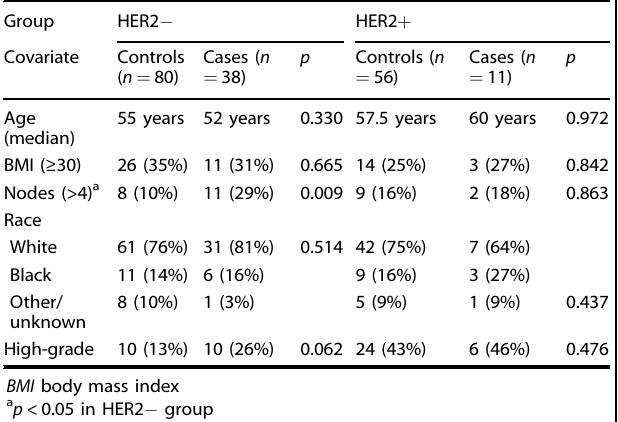
Table 1. Clinical characteristics of HER2 − and HER2 + patients.